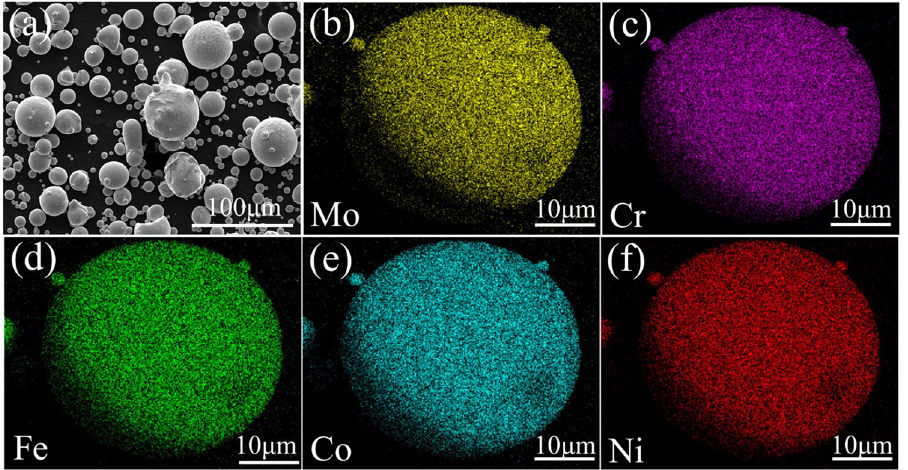
Figure 2: ( a ) SEM image of Co 28.5 Cr 21.5 Fe 20 Ni 26 Mo 4 MEAs powders, ( b ) distribution of Mo element, ( c ) distribution of Cr element, ( d ) distribution of Fe element, ( e ) distribution of Co element, and ( f ) distribution of Ni element.